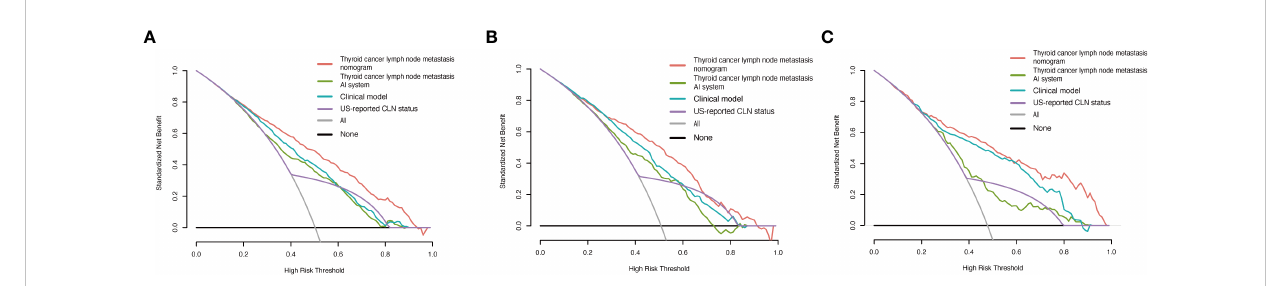
FIGURE 5 Decision curve analysis of the thyroid cancer lymph node metastasis nomogram, thyroid cancer lymph node metastasis AI system, clinical model and US-reported CLN status in PTC patients. (A) Decision curve analysis for predicting CLNM in the training cohort. (B) Decision curve analysis for predicting CLNM in the internal validation cohort. (C) Decision curve analysis for predicting CLNM in the external validation